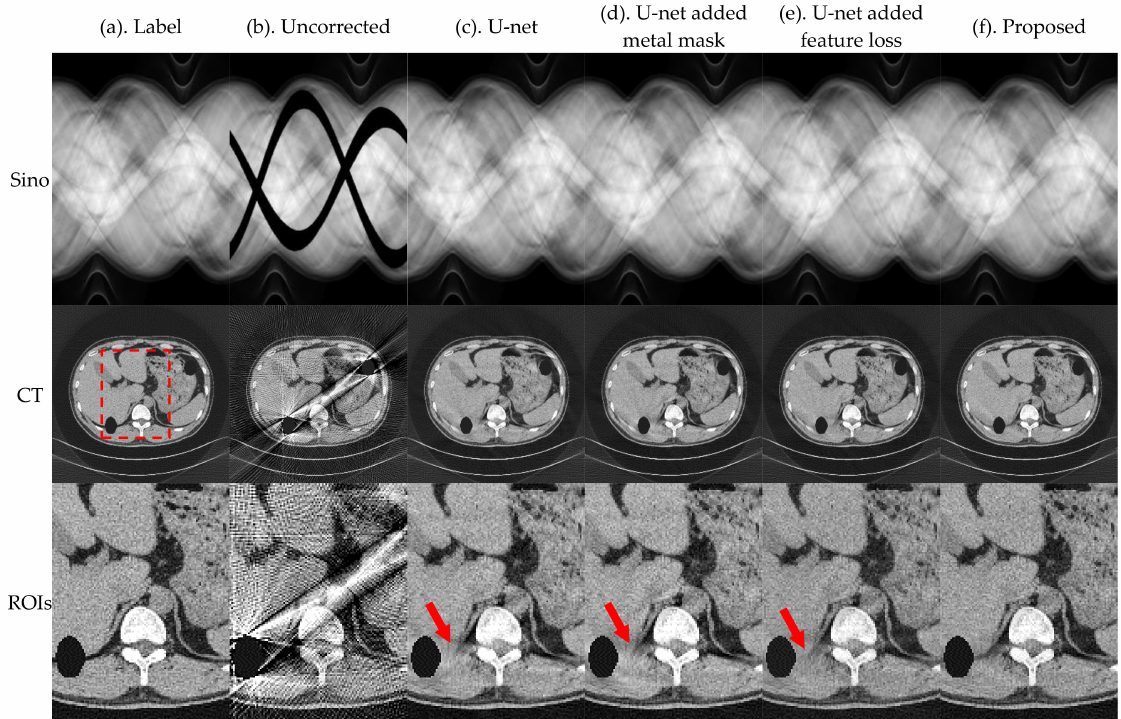
Figure 11. Simulation results of the pleural, where the first row is the sinogram, and the second row is the FBP reconstruction results. The display window of sinogram is (0, 1). The display window of CT is ( − 0.1,